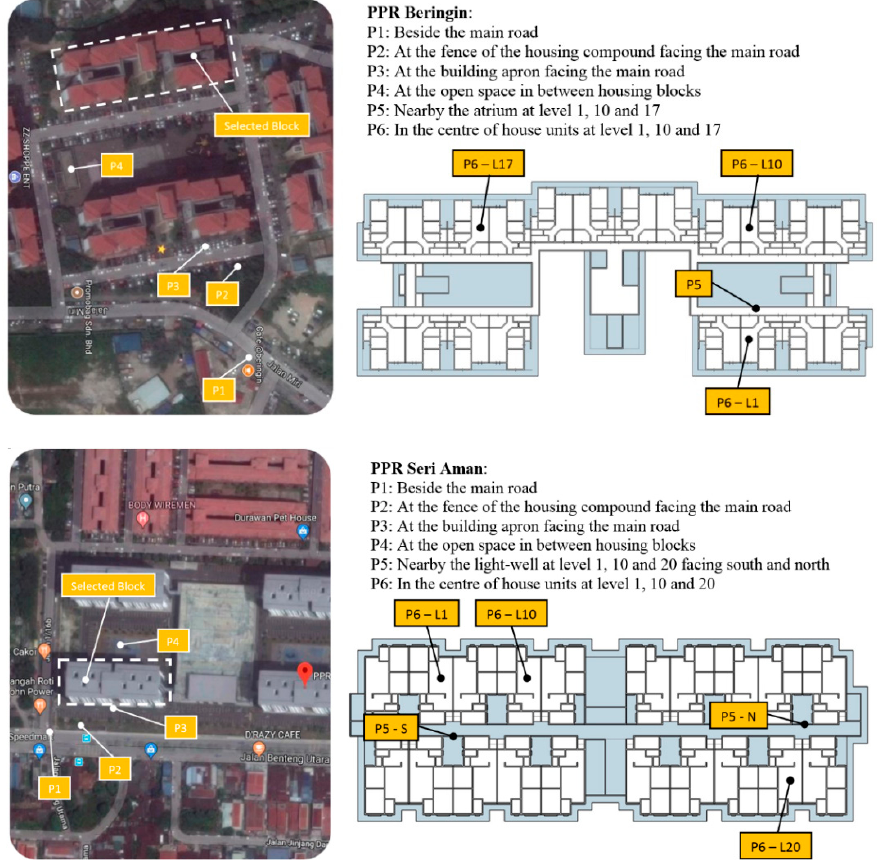
Figure 10. Locations of the outdoor, semi-outdoor, and indoor measurement points in the PPR Beringin and PPR Seri Aman.